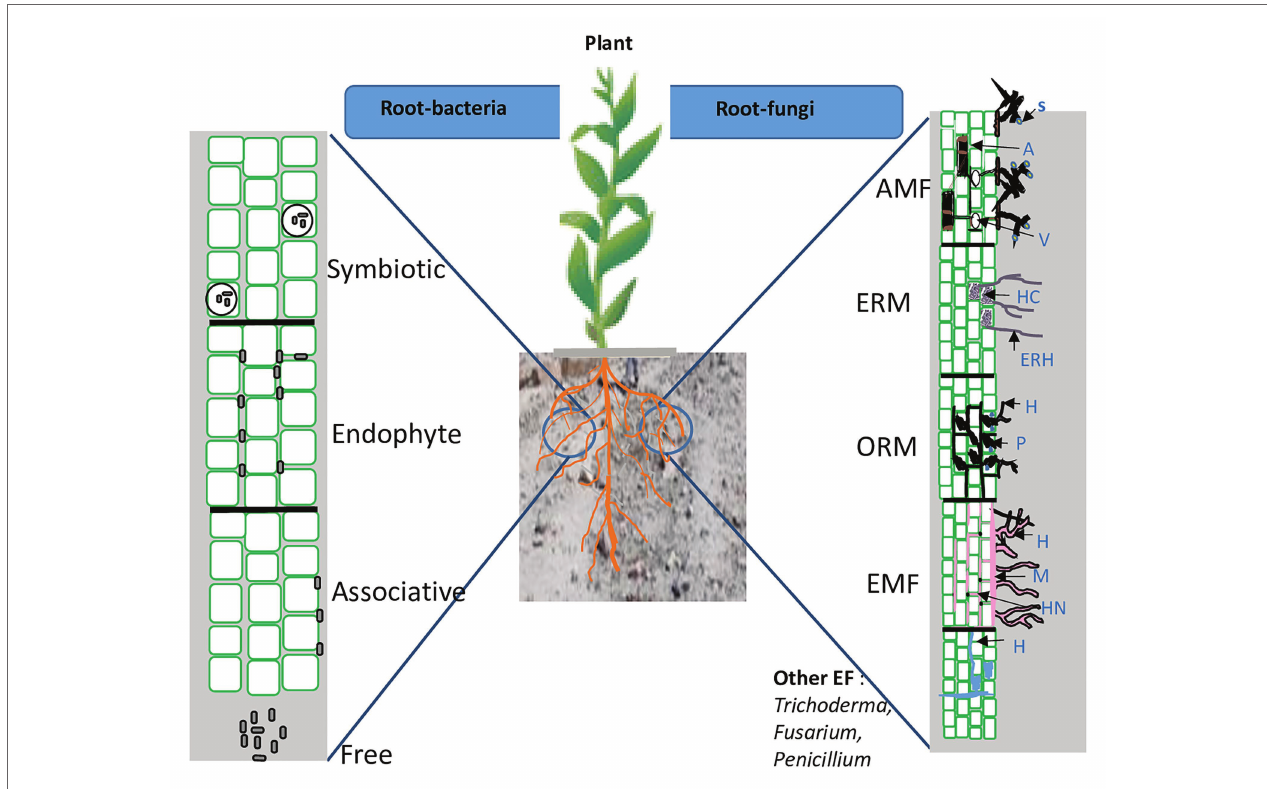
FIGURE 3 | Schematic representation of root and rhizosphere colonization by beneficial microorganisms. AMF, arbuscular mycorrhizal fungi; ERM, ericoid mycorrhizal fungi; OMF, orchid mycorrhizal fungi; EMF, ectomycorrhizal fungi; EF, endophyte fungi; A, arbuscules; ERH, extraradical hyphae; V, vesicles; S, spore; HC, hyphal coils; P, peloton; HN, Hartig net; and M,